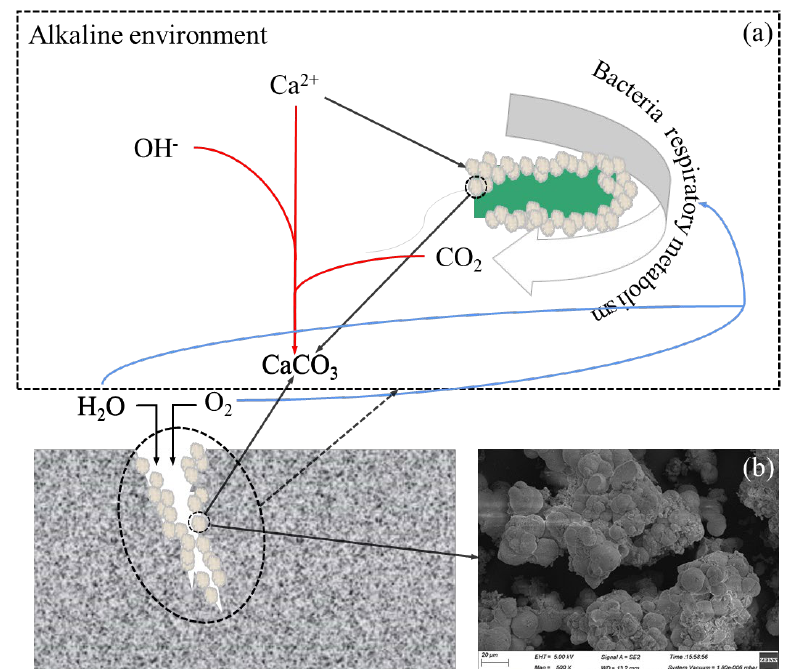
Figure 1. The principles and process of MICP technology for crack healing: ( a ) Microbially induced CaCO 3 precipitation in cement-based material cracks; ( b ) Morphology of calcite formed by microbial induction.